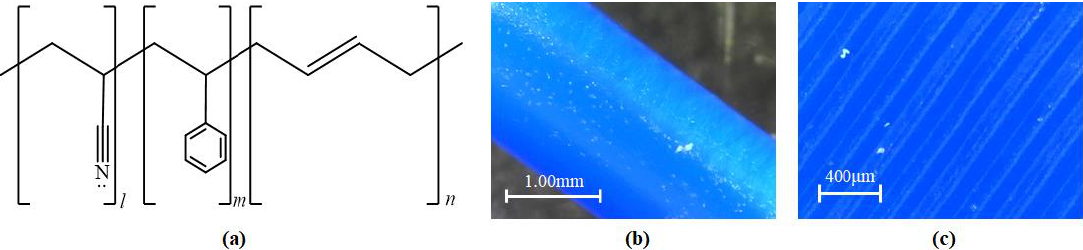
Figure 7. ABS ( a ) chemical structure; ( b ) raw material; and ( c ) final processed material.